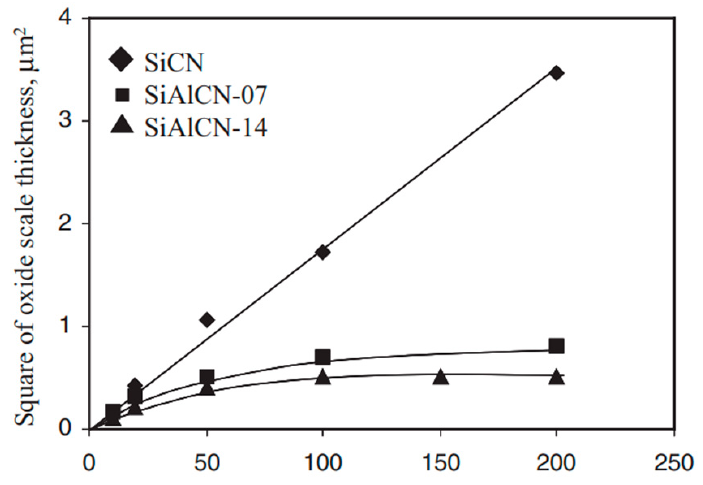
Figure 5. A plot of the square of oxide scale thickness as a function of annealing time for SiCN and SiAlCN ceramics at 1200 °C [72].